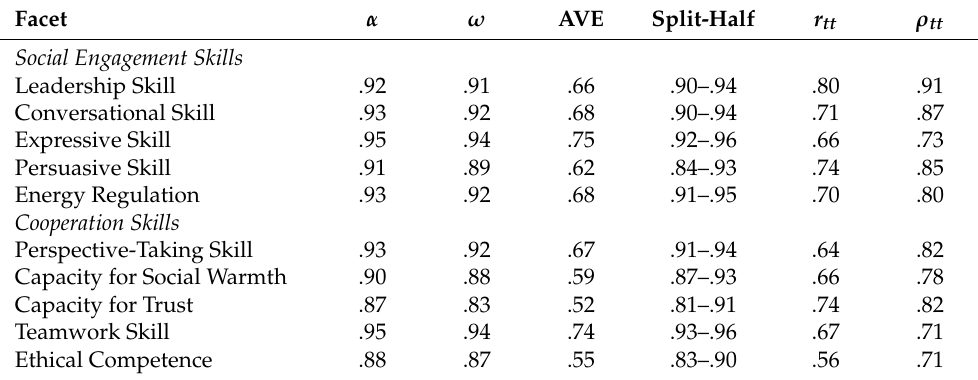
Table 2. Reliabilities of the 32 facets of BESSI-G v0.2 with 8-month test–retest stabilities and true-score correlations (Study